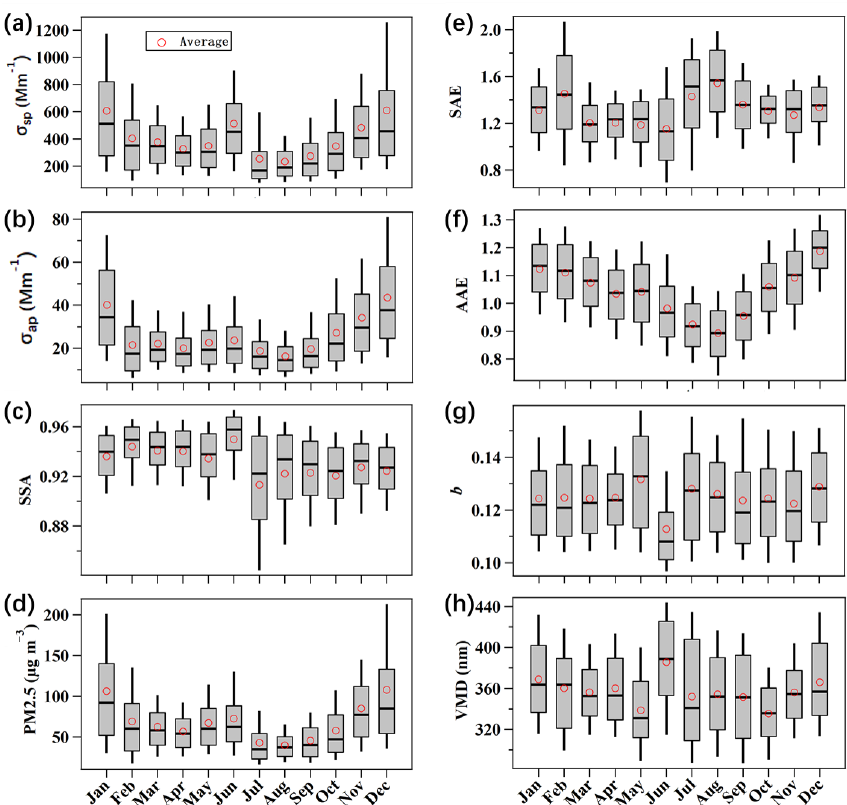
Figure 3. Seasonal cycle of selected aerosol optical properties and supporting parameters at SORPES. (a) Scattering coefficient at 525nm, (b) absorption coefficient at 520nm, (c) backscatter fraction at 525nm, (d) single-scattering albedo at 520nm, (e) scattering Ångström exponent between 450 and 635nm, (f) absorption Ångström exponent between 370 and 950nm, (g) PM 2 . 5 concentration and (h) volume mean diameter for 6–800nm particles. The solid lines represent median values, red cycles stand for averages, the boxes are 25 and 75th percentiles, and the whiskers represent the 10th and 90th